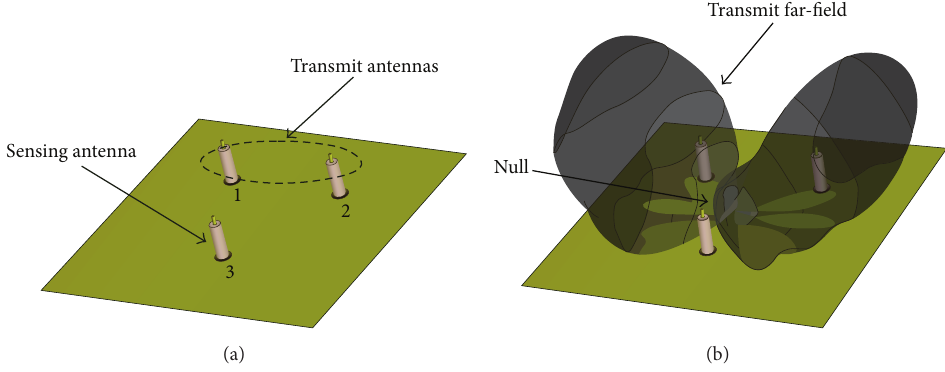
Figure 14: (a) The numerical model of the array prototype comprised of three short monopoles and (b) the far-field beam pattern when out-phasing the transmit antennas